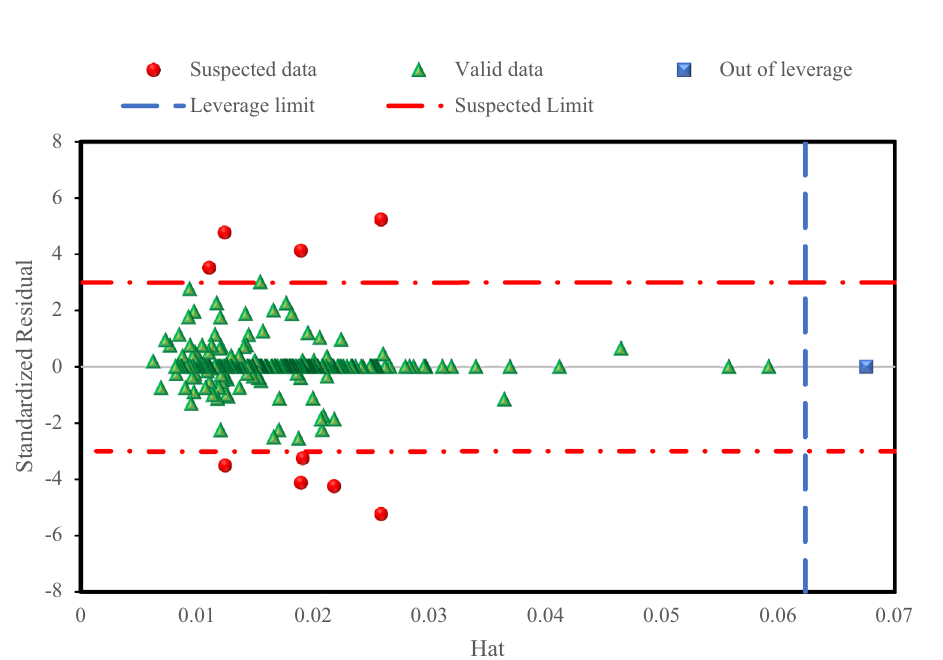
Figure 12. William’s plot for the outlier detection using the Random Forest